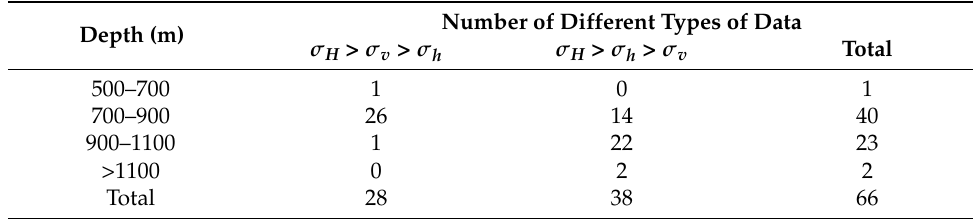
Table 3. Distribution of in-situ stress field types with